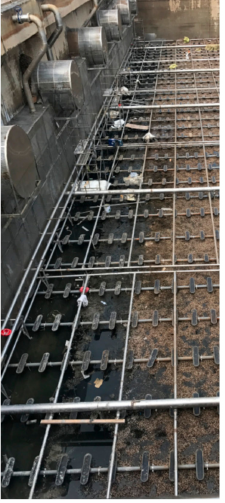
Figure 2. The aeration systems